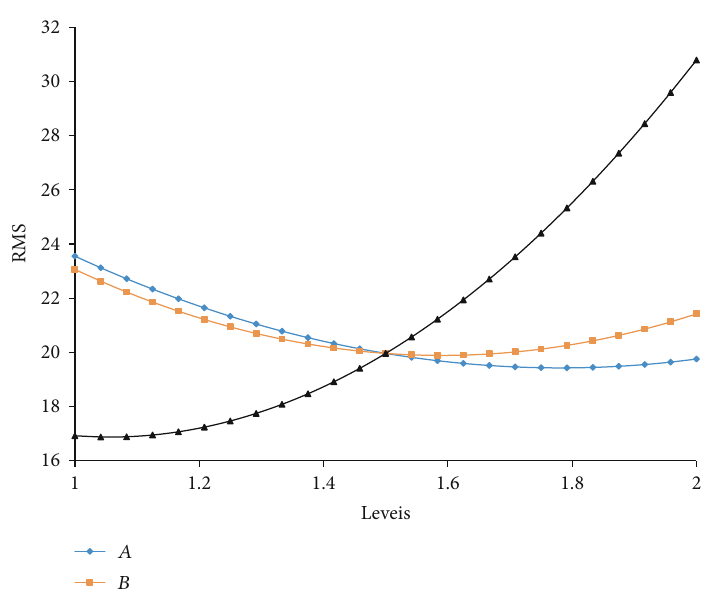
Figure 19: Pareto chart for the RMS.